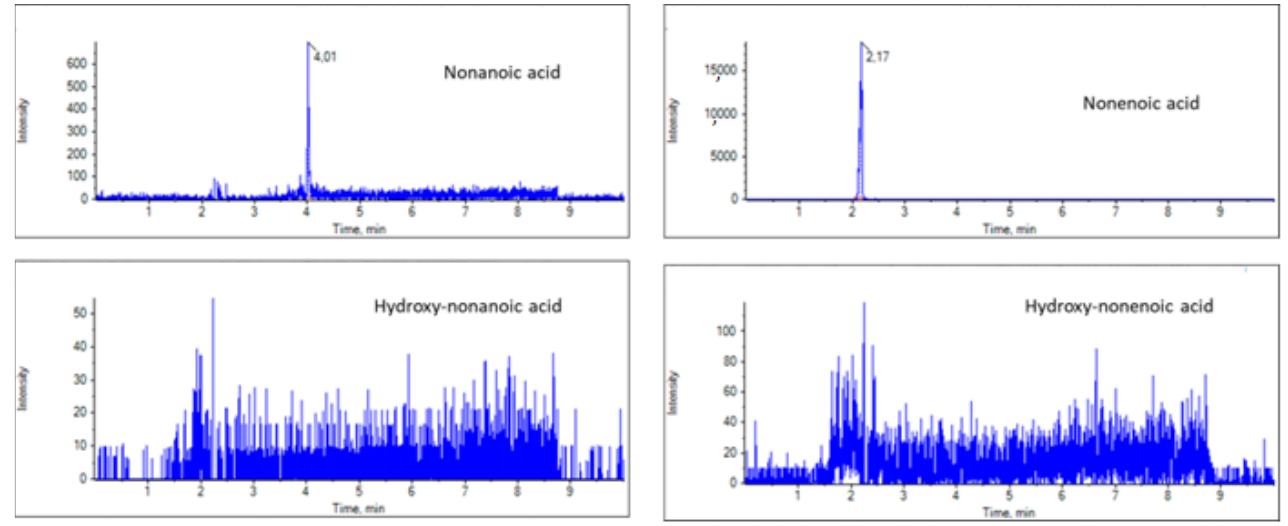
Figure 3. EICs of nonanoic, nonenoic, hydroxynonanoic and hydroxynonenoic acids in a representa- tive RJ sample.